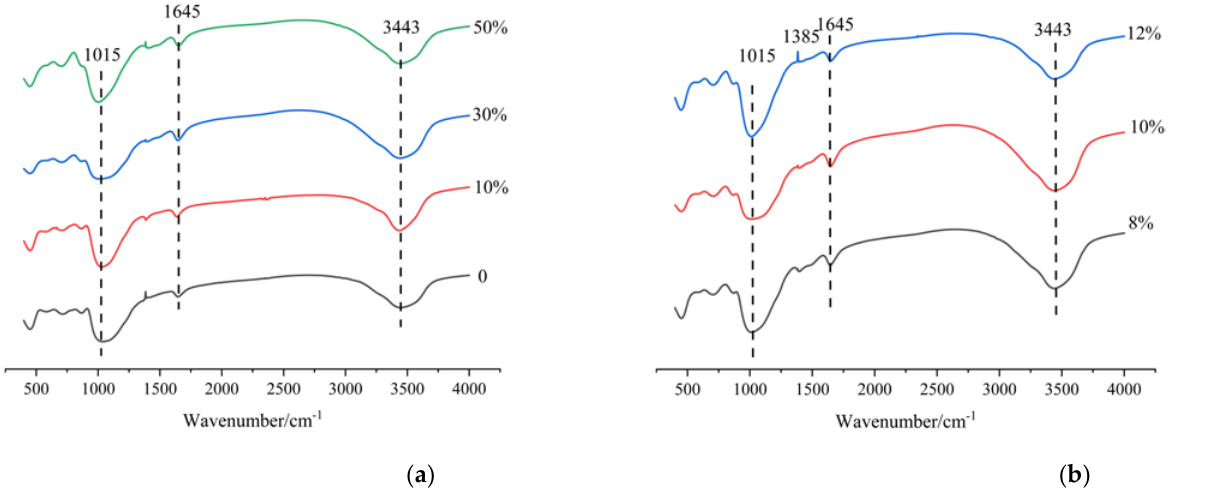
Figure 8. FT−IR spectra of AAMS composite cementitious materials. ( a ) Different slag contents. ( b ) Different Na 2 O contents.